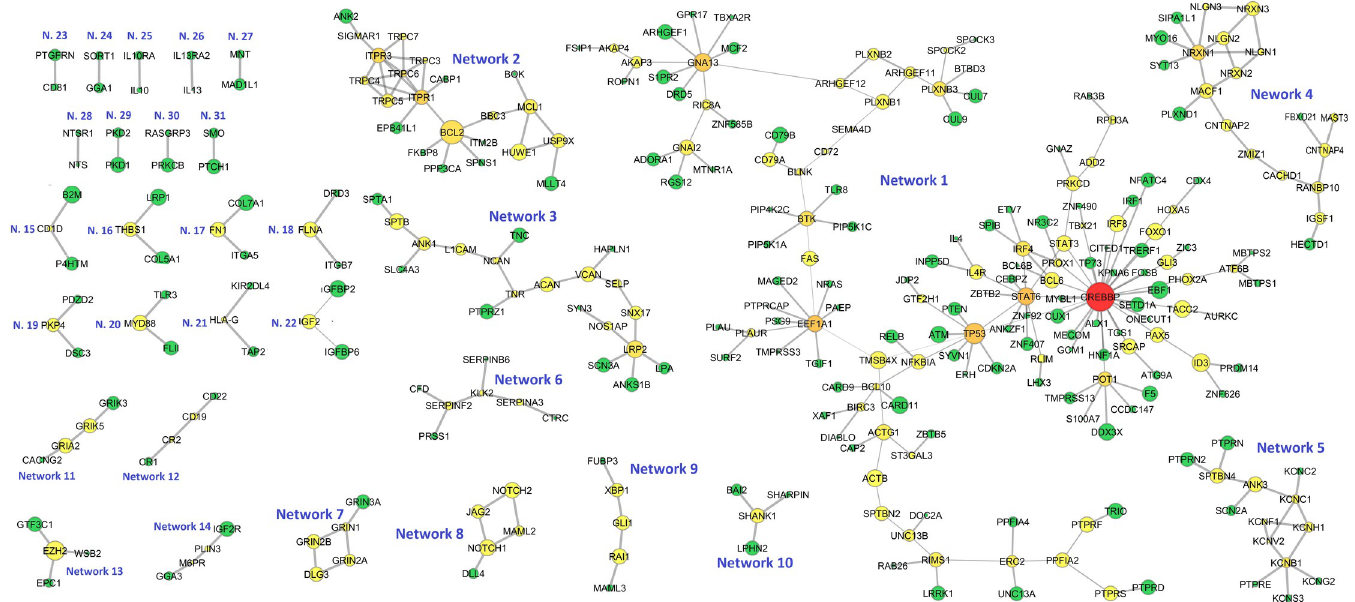
Fig 3. Representation of all significantly mutated protein subnetworks according to Hierarchical HotNet results. Node size is proportional to mutation frequency, node color is proportional to node degree (red: higher degree values, green: lower degree values) and edge width is proportional to betweenness centrality.